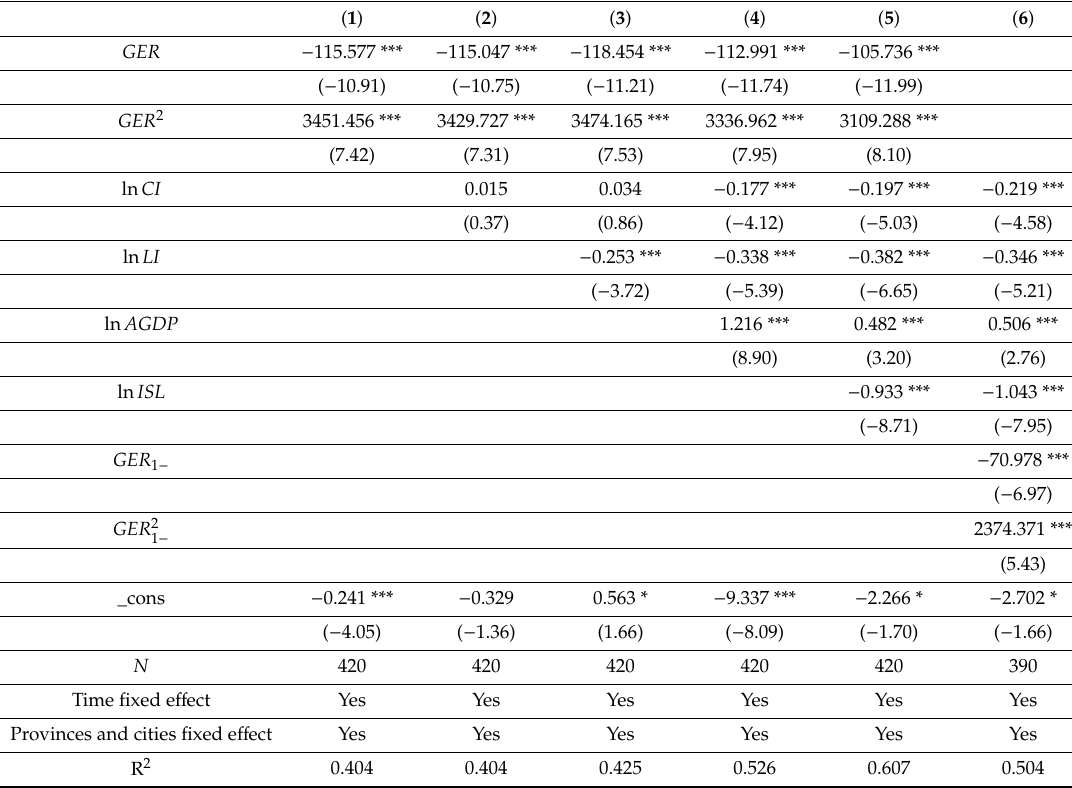
Table 1. Regression results of the econometric